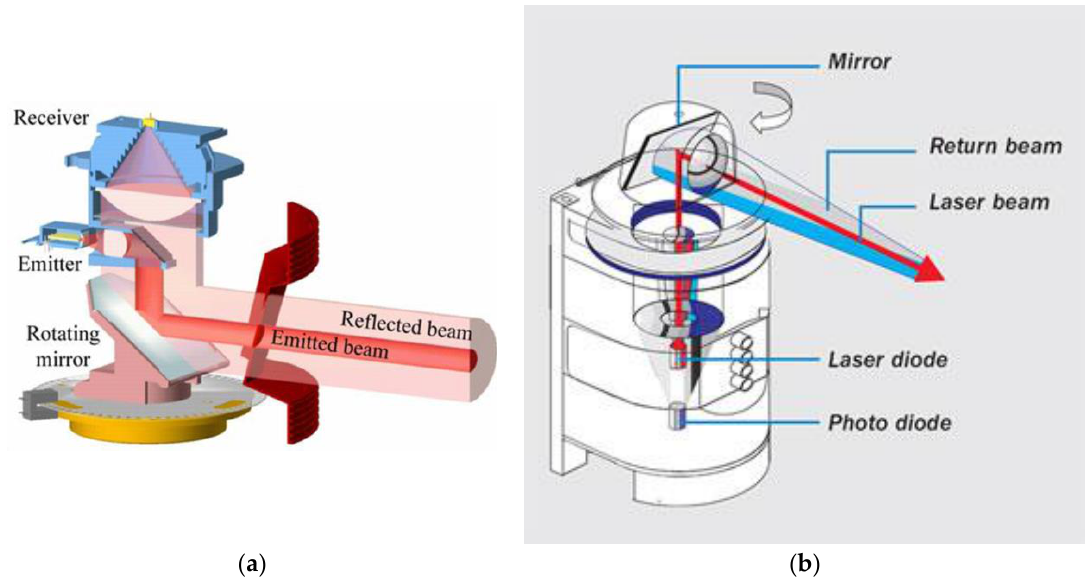
Figure 6. Typical 2D scanning mechanism used in ( a ) SICK 2D LiDAR ( b ) SICK omnidirectional LiDAR.